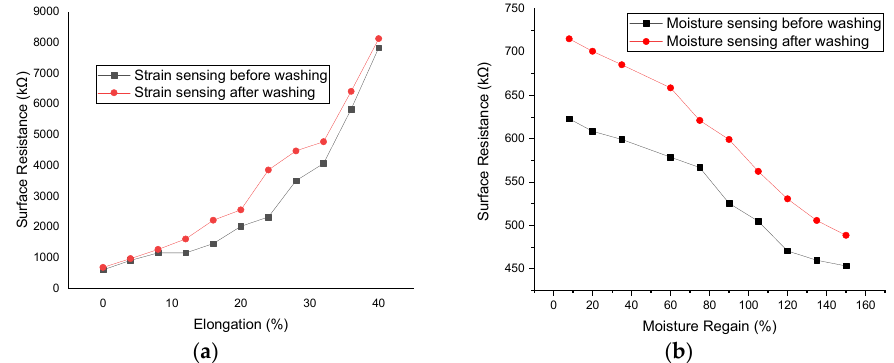
Figure 4. Dynamic responses in sheet resistance: ( a ) Stretching; ( b ) moisture